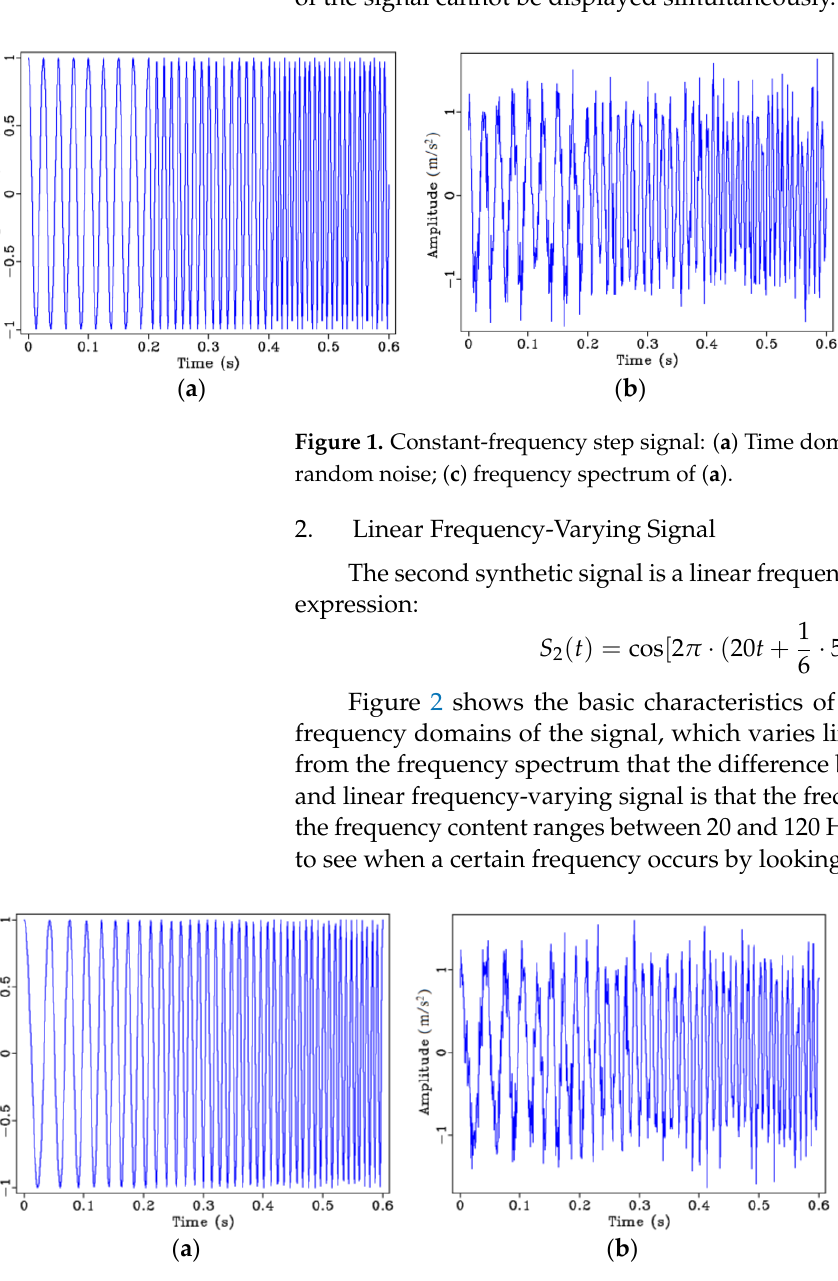
Figure 2. Linear frequency-varying signal: ( a ) Time domain signal; ( b ) time domain signal with 10% random noise; ( c ) frequency spectrum of ( a ).